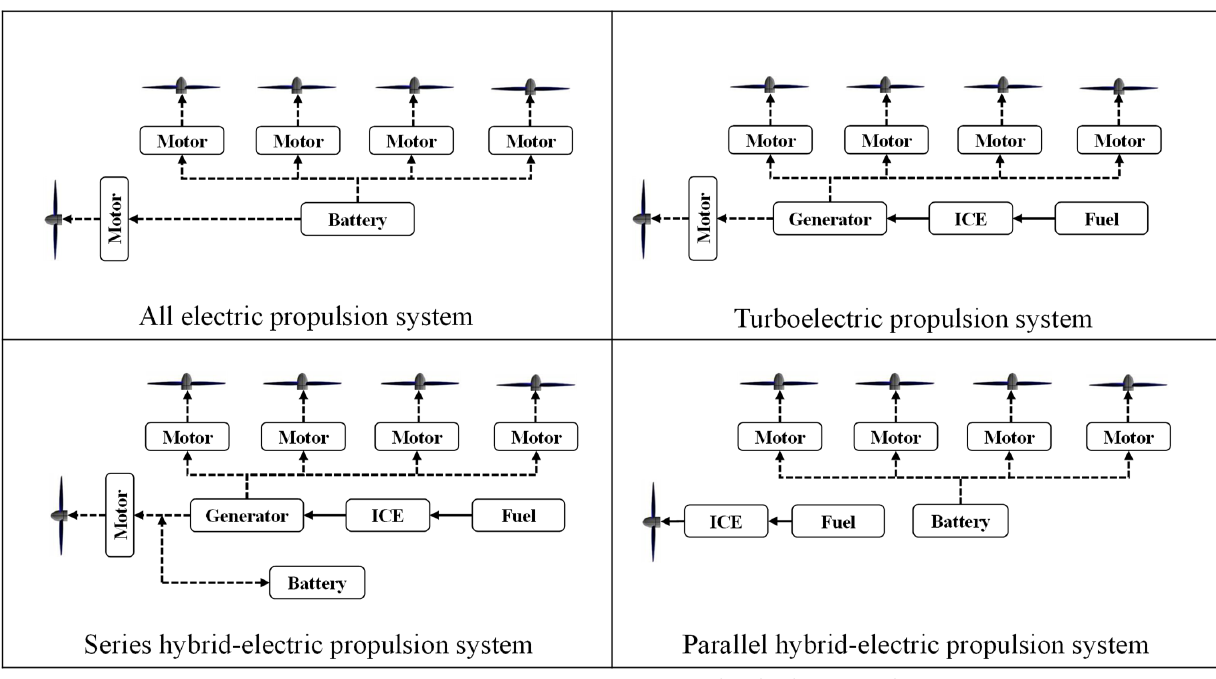
Figure 2. Schematic diagram of four electric propulsion configurations.